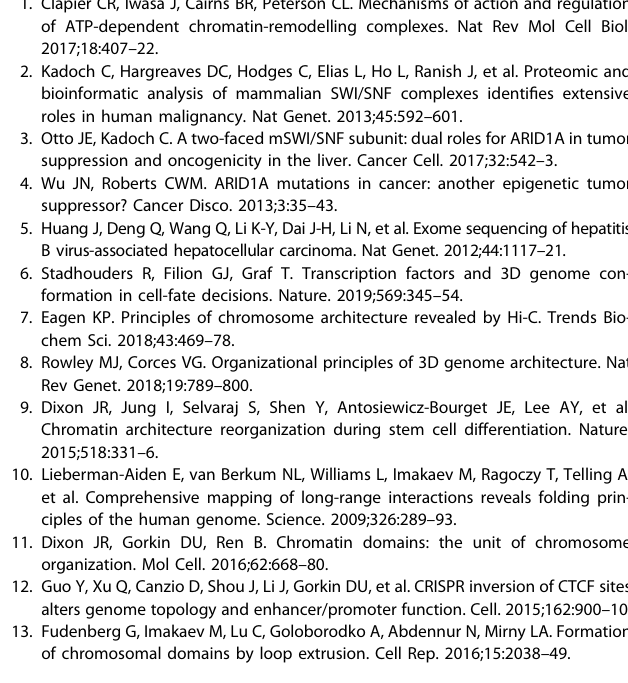
Fig. 6 ARID1A de fi ciency promotes liver cancer cell metastasis via dysregulation on PMP22 and GSC . A Immunoblotting on Pmp22 and Gsc in liver tissues of 3 and 14 month old Arid1a fl / fl mice and Arid1a LKO littermates. B Representative IHC staining (Left) and quanti fi cation of positive staining (Right) for Pmp22 and Gsc in liver tissues of 3-month-old Arid1a fl / fl mice and Arid1a LKO littermates. Scale bar = 50 μ m. Data are presented as the mean ± SEM ( n = 5 per group). * p < 0.05, ** p < 0.01, calculated by a two-tailed Student ’ s t -test. C Representative images of invasive MHCC-97H cells transfected with Pcdh-PMP22 construct; lentiviral shARID1A-1, and ARID1A -knockdown cells co-transfected with Pcdh-PMP22 in transwell assays (Scale bar, 100 µm) (Left) and quanti fi cation of the invasive cells (Right). Data are shown as mean ± SEM of three independent experiments. * p < 0.05, ** p < 0.01, calculated by a two-tailed Student ’ s t -test. D Representative images and quanti fi cation of the invasive MHCC-97H cells treated with the indicated lentiviral shRNA plasmids for ARID1A (shARID1A-1) and GSC (shGSC-1) in transwell assays. E The relapse-free survival and the overall survival in HCC patients with high or low expression of PMP22 (Left) and GSC (Right), examined by Kaplan-Meier analysis. F Schematic diagram of the dysregulated mechanism related to PMP22 and GSC loci upon ARID1A de fi ciency. Based on our data, we proposed the working model of the SWI/SNF complex in maintaining chromatin organization mediated by the BRG1-RAD21 axis in hepatocytes. Once ARID1A is de fi cient, the chromatin loop tethering promoter to the enhancer of Pmp22 might be weakened due to the attenuated anchorage force arising from insuf fi cient BRG1 (Top); the unaided boundaries lead to TAD remodeling surrounding Gsc locus to some extent